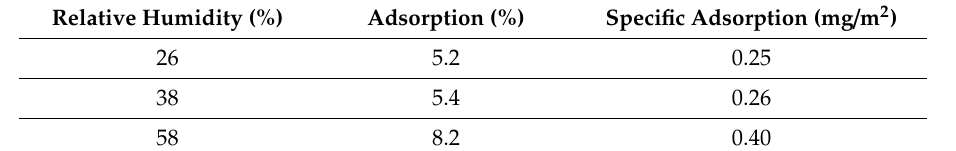
Table 2. Impact of ambient relative humidity on the change in mass of GoHAP-1 (10 nm) samples.